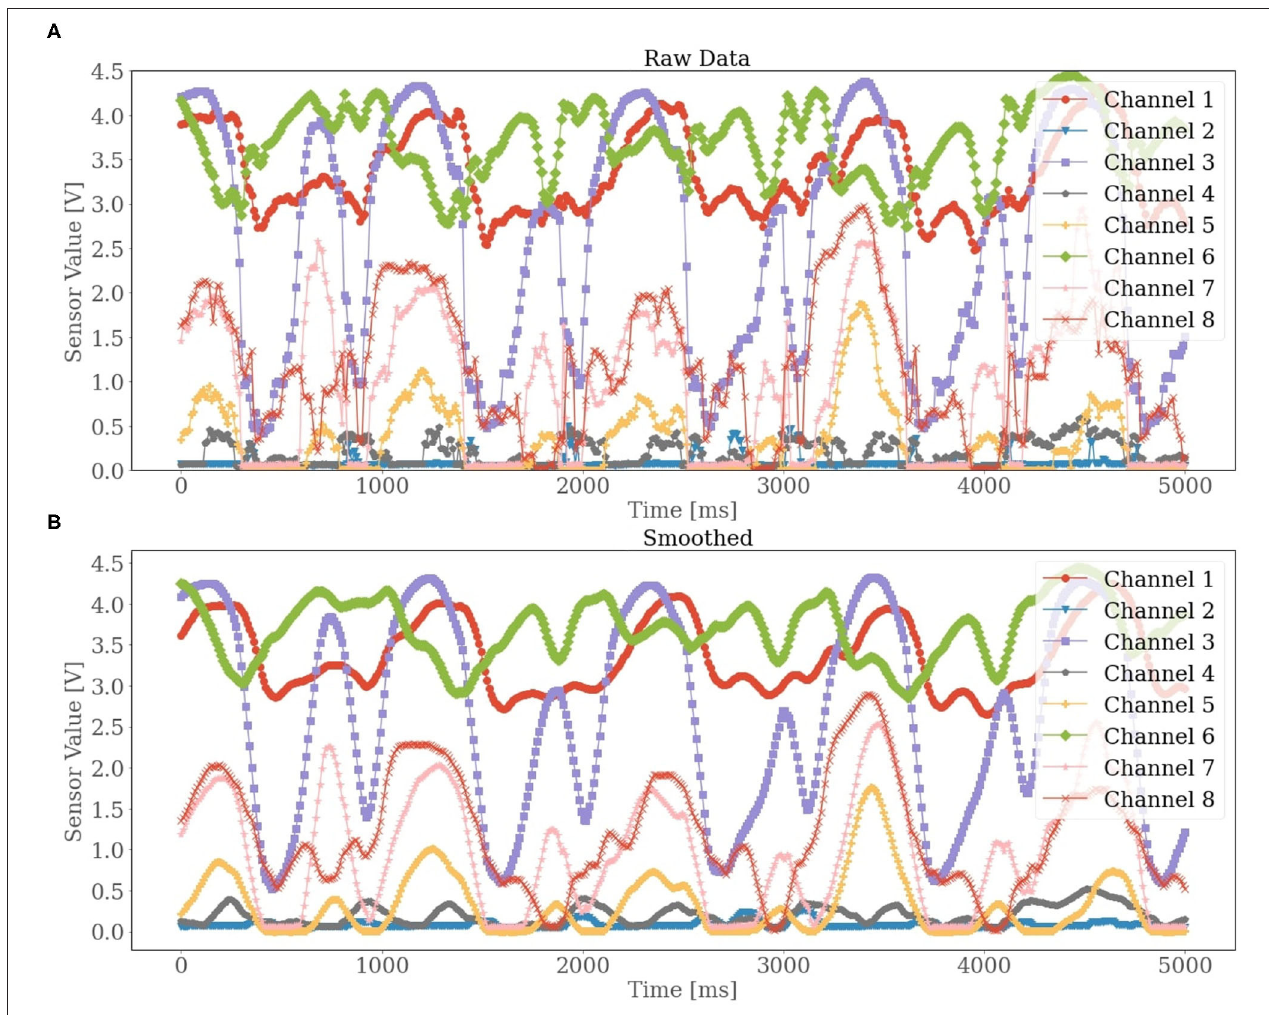
FIGURE 2 | A given example of the raw data collected from the force myography (FMG) strap. The 8 channels correspond to the 8 force resisting sensor (FSR) sensors, respectively. In diagram (A) , the raw unfiltered sensor values are presented, while in diagram (B) the smoothed sensor values are displayed. the time signal into discrete frequencies. After